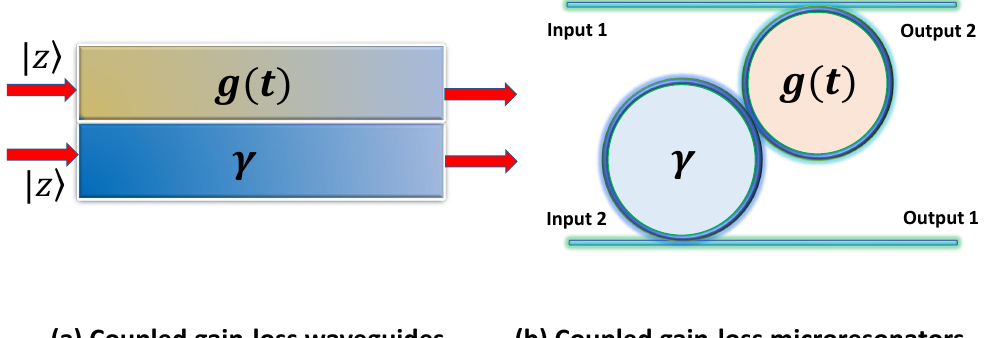
Figure 1. Exemplary setups, as the coupled waveguides and the coupled microresonators driven by a coherent field, which carry gain–loss media. The inputs | z (cid:105) are squeezed vacuum or squeeze coherent states. The gain, loss, and coupling are denoted by g , γ , and J ,